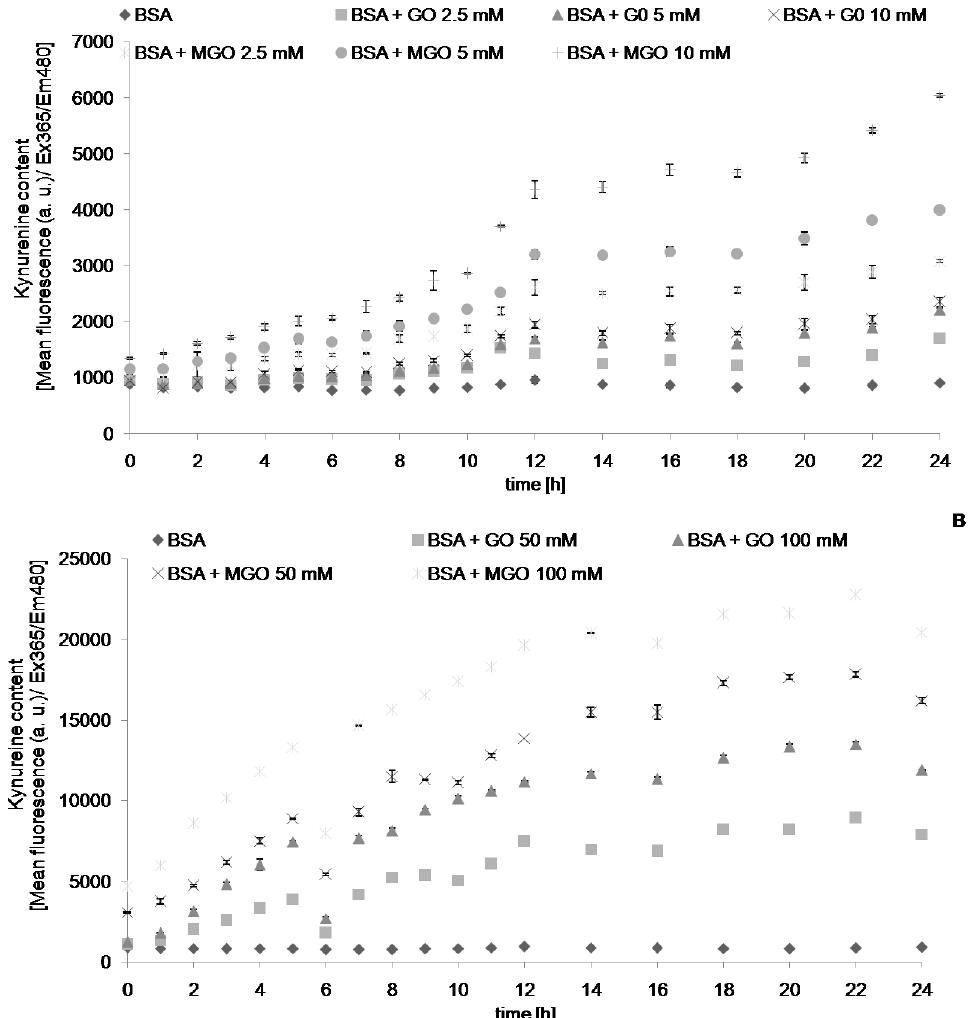
Figure 4. The time course of kynurenine fluorescence during incubation of BSA (0.09 mM) with 2.5, 5 and 10 mM ( A ), and 50 and 100 mM ( B ) GO and MGO at 37